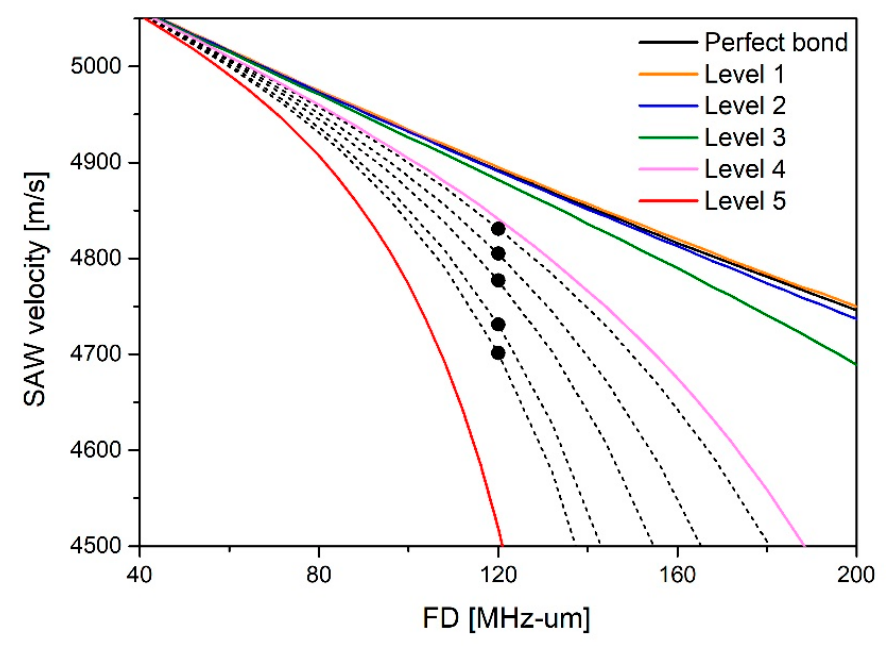
Figure 5. Results of SAW velocity on dispersion curve by interface condition.